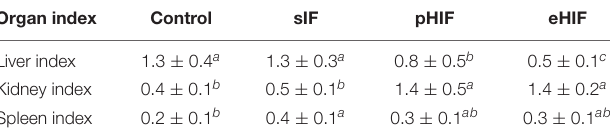
TABLE 3 | Effects of infant formula on organ index in